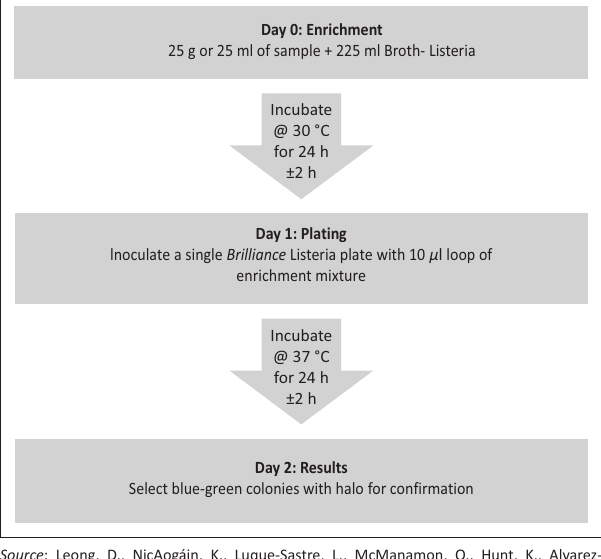
FIGURE 6: The illustration of ONE-Broth